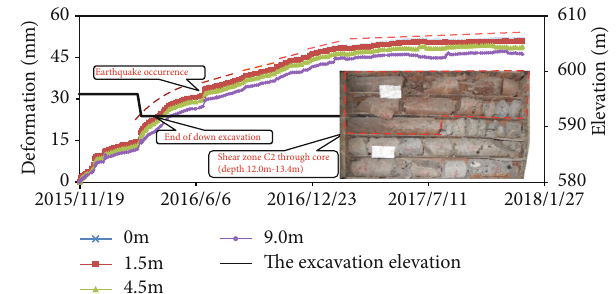
Figure 5: Time-displacement curve of surrounding rock a ff ected by weak interlayer.